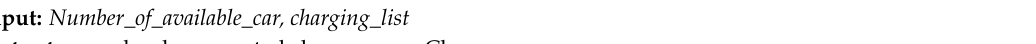
Algorithm 2. Algorithm for generating chromosome instances